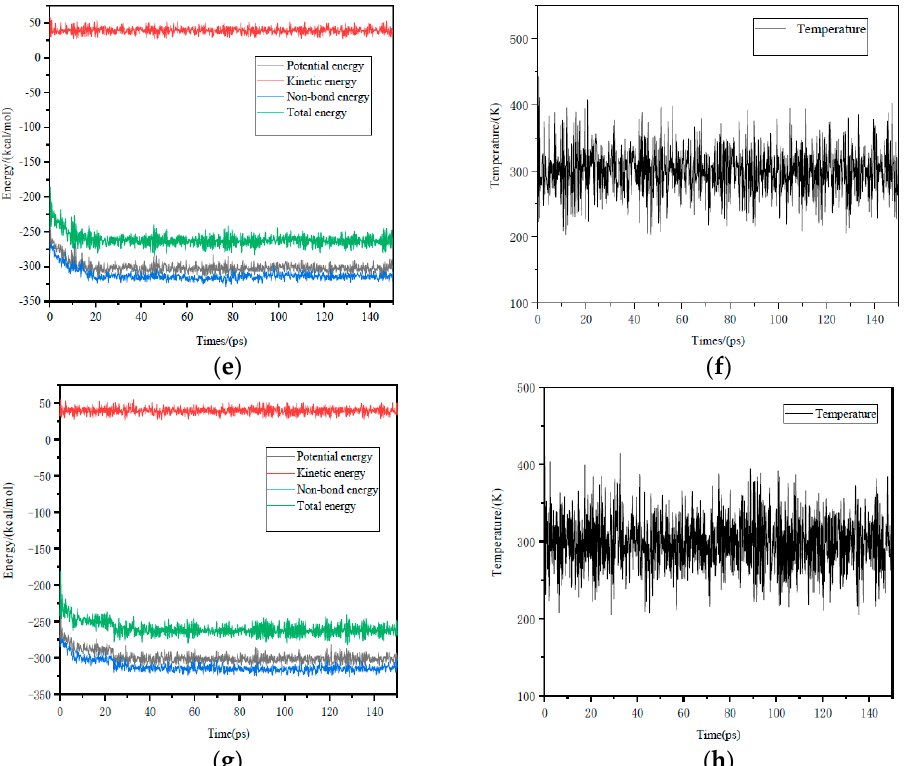
Figure 4. Molecular dynamics simulation of different metal oxides with ChCl-2MA. Dynamic simulation of ChCl-2MA on ZnO (001) surface (( a ): energy change ( b ): temperature change). Dynamic simulation of ChCl-2MA on Fe 2 O 3 (001) surface (( c ): energy change ( d ): temperature change). Dynamic simulation of ChCl-2MA on Al2O3 (001) surface (( e ): energy change ( f ): temperature change). Dynamic simulation of ChCl-2MA on CaO (001) surface (( g ): energy change ( h ): temperature change).